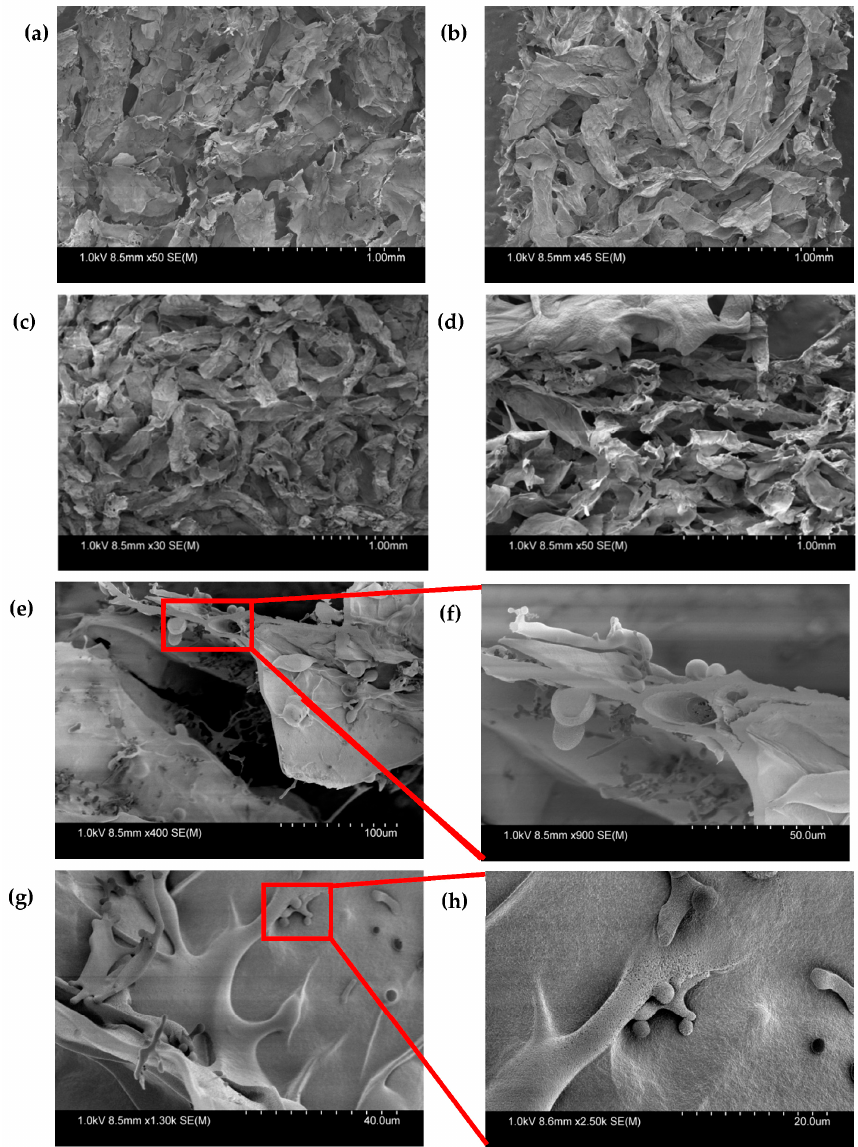
Figure 10. SEM images revealed morphological characteristics and interconnectivity of pores of bioprinted constructs. ( a ) Horizontal section of bioprinted constructs without microspheres. ( b ) Vertical section of bioprinted constructs without microspheres. ( c ) Horizontal section of bioprinted constructs with microspheres. ( d ) Vertical section of bioprinted constructs with microspheres. ( e ) At 100 um, horizontal section of bioprinted constructs showing microspheres are embedded in the bioprinted construct. ( f ) At 50 um, horizontal section of bioprinted constructs showing microspheres are em- bedded in the bioprinted construct. ( g ) At 40 um, vertical section of bioprinted constructs showing microspheres embedded in the bioprinted construct. ( h ) At 20 um, vertical section of bioprinted constructs showing microspheres embedded in the bioprinted